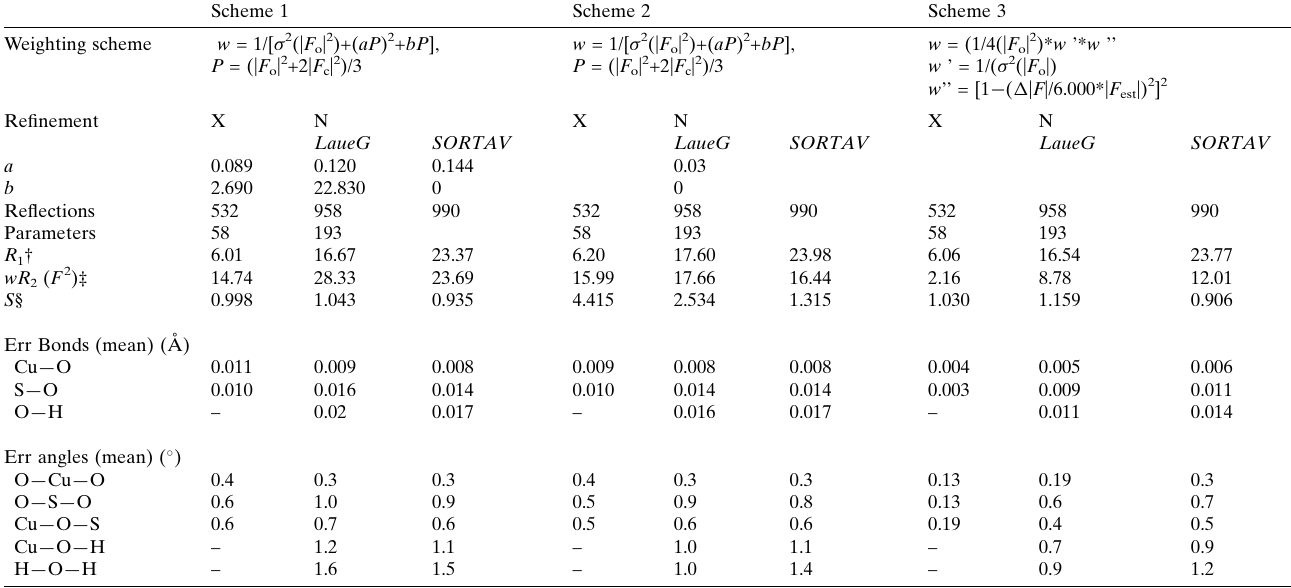
Table 2 Crystallographic information for copper sulfate pentahydrate at 0.71 GPa from X-ray and neutron data collections performed at 295 K. All single-crystal diffraction data were refined against F 2 . All agreement factors are given as percentages. The number of reflections refers to those used in the refinement. Omitted estimated standard deviations in the intramolecular geometries indicate that those parameters were not refined in the X-ray refinement. Scheme 1 Scheme 2 Weighting